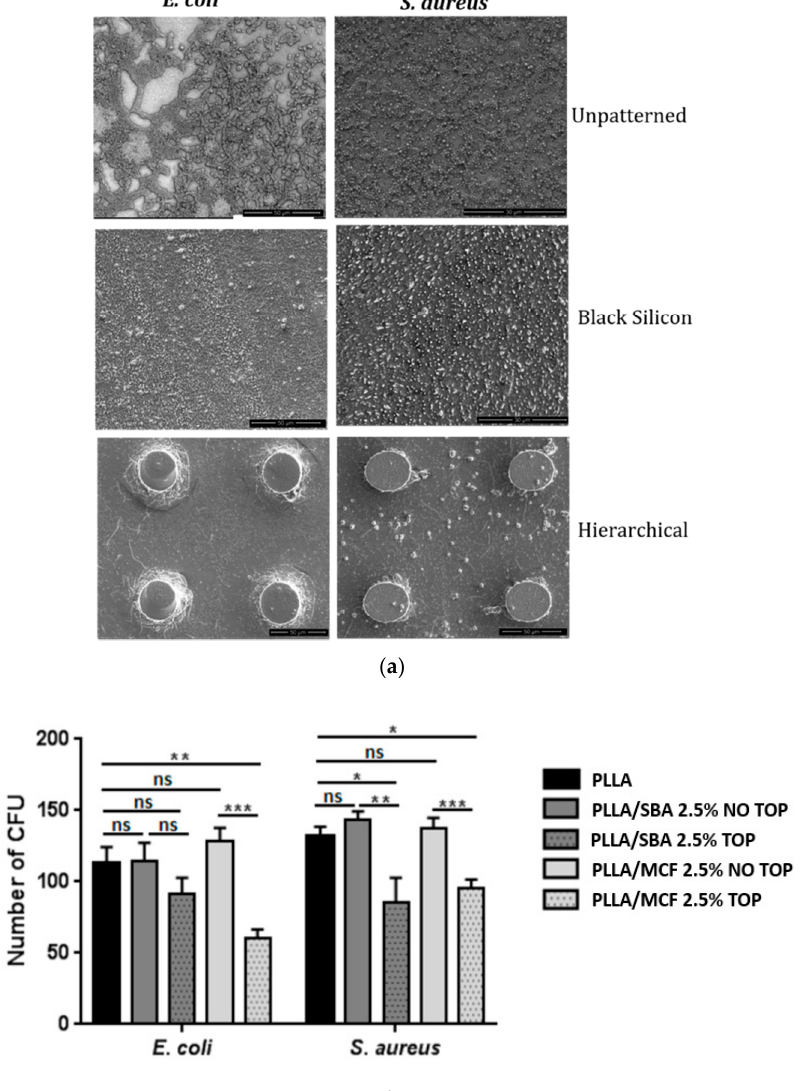
Figure 9. ( a ) SEM analysis, the reference strain SEM observations of “rod-shaped” E. coli and “coccoid-shaped” S. aureus on flat unpatterned, black silicon, and hierarchical domains on the surface of the PLA films [136]. ( b ) Number of CFU formed on the surface of the films prepared in this work [138].